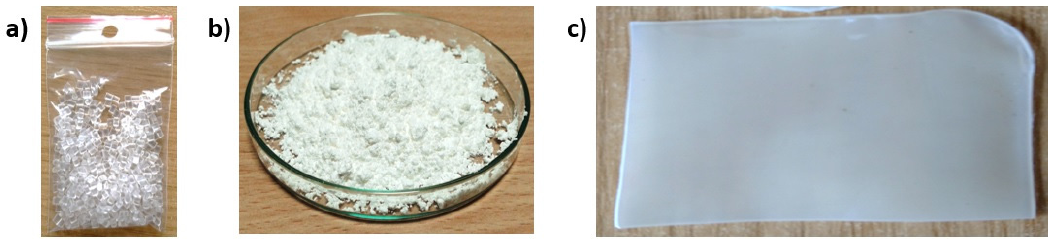
Figure 6. Images of ( a ) the polymer matrix (ethylene–norbornene copolymer), ( b ) the cellulose powder, and ( c ) the polymer composite sample.